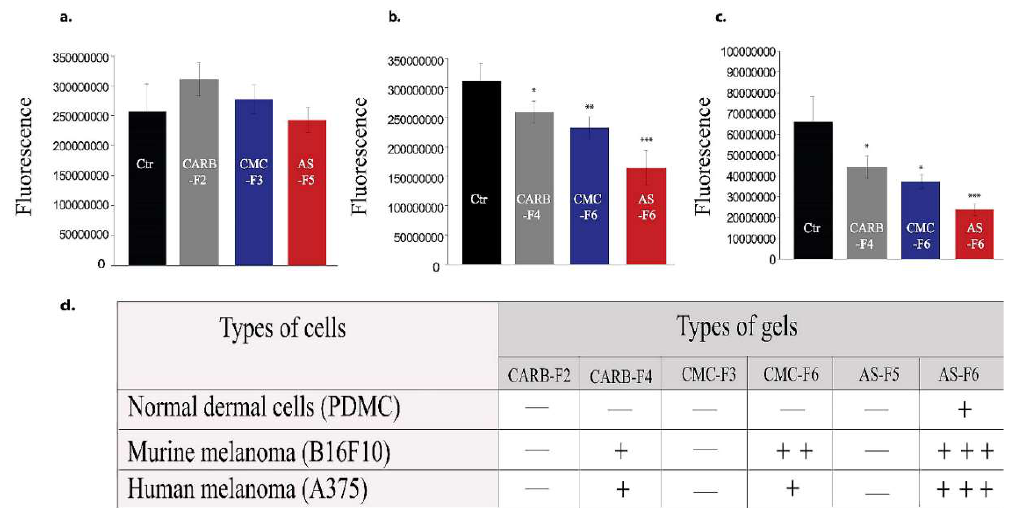
Figure 5. Viability of normal dermal cells (Primary Dermal Endothelial Cells (PDMC)) for gel formulations without and with CD-NHF ( N = 15 wells/column from two independent experiments). Ctr (Control).